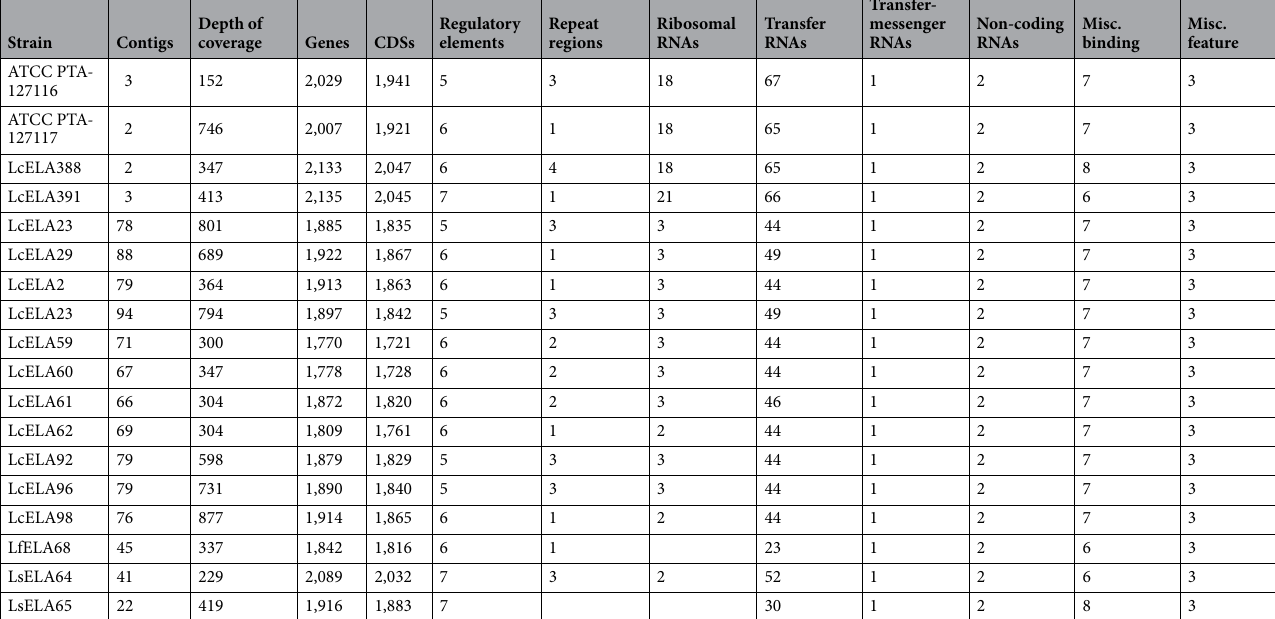
Table 5. Genomic properties of Latilactobacillus strains.